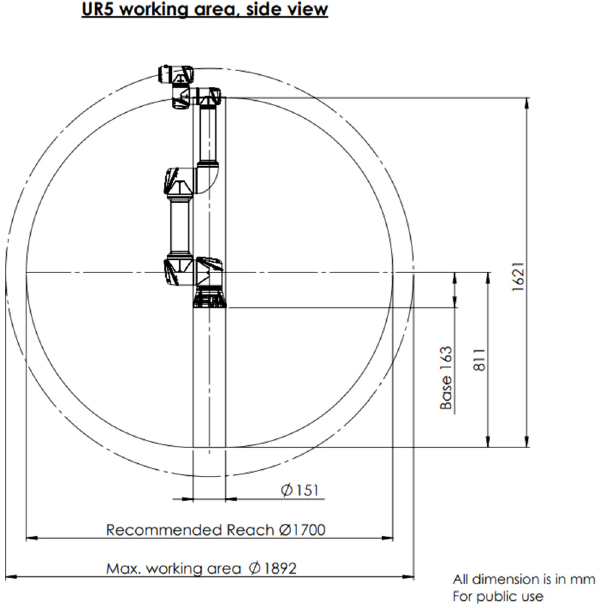
Figure 13. The working area of the UR5 robot.